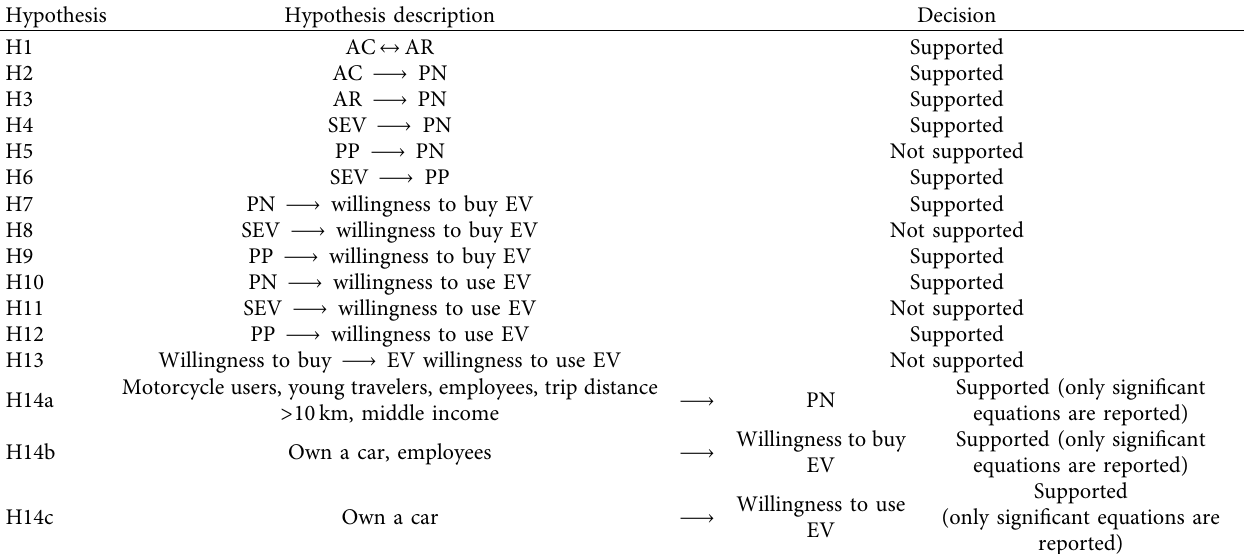
Table 6: Results of hypothesis